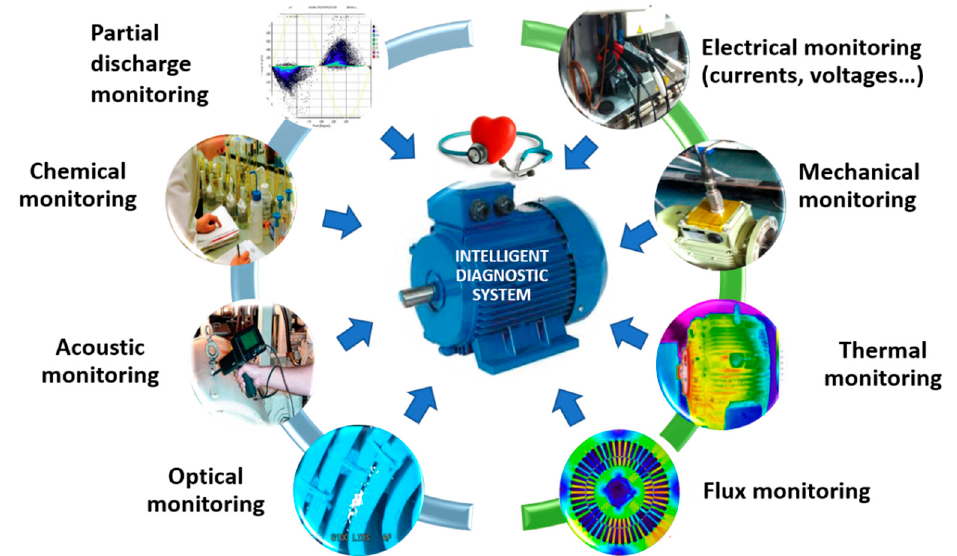
Figure 1. Recent trend in the electric motors condition monitoring area based on the integration of the monitoring of different motor quantities for the development of intelligent diagnostic systems.